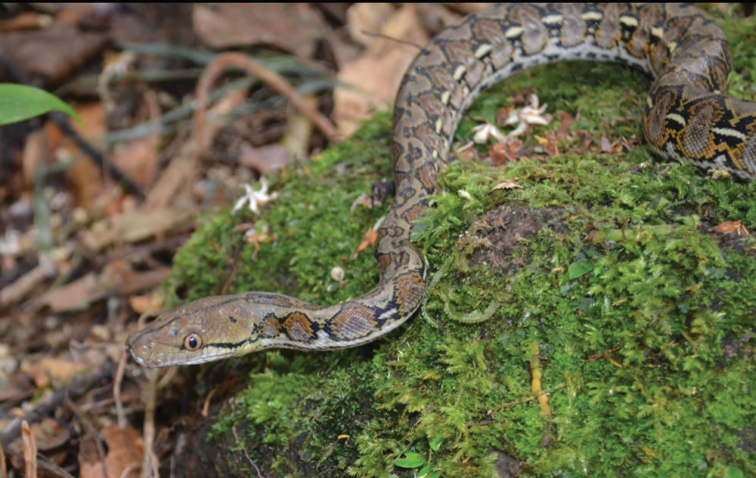
Subadult maleBroghammerus reticulatus (KU 330021) at Location 1a. Photo: JS.